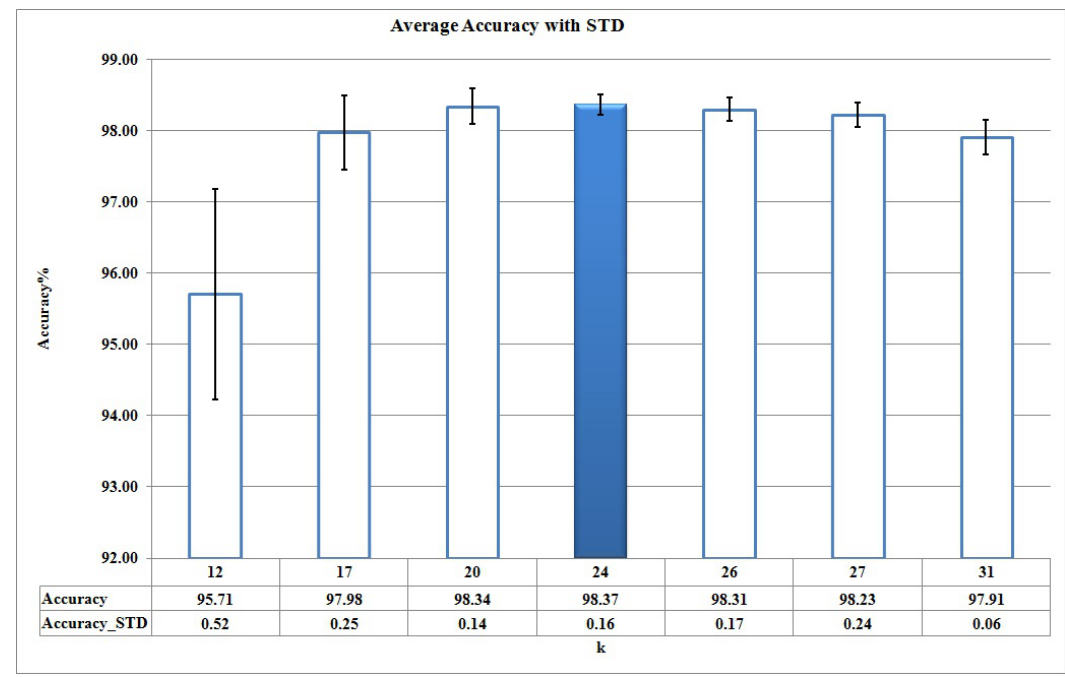
Figure 7. Accuracy for different candidate values of k based on Figure